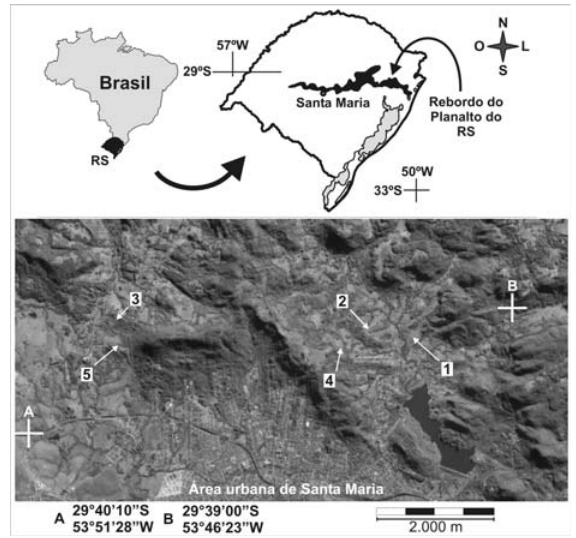
Figura 1. Localização das cinco áreas de coleta dos perfis de Neossolos